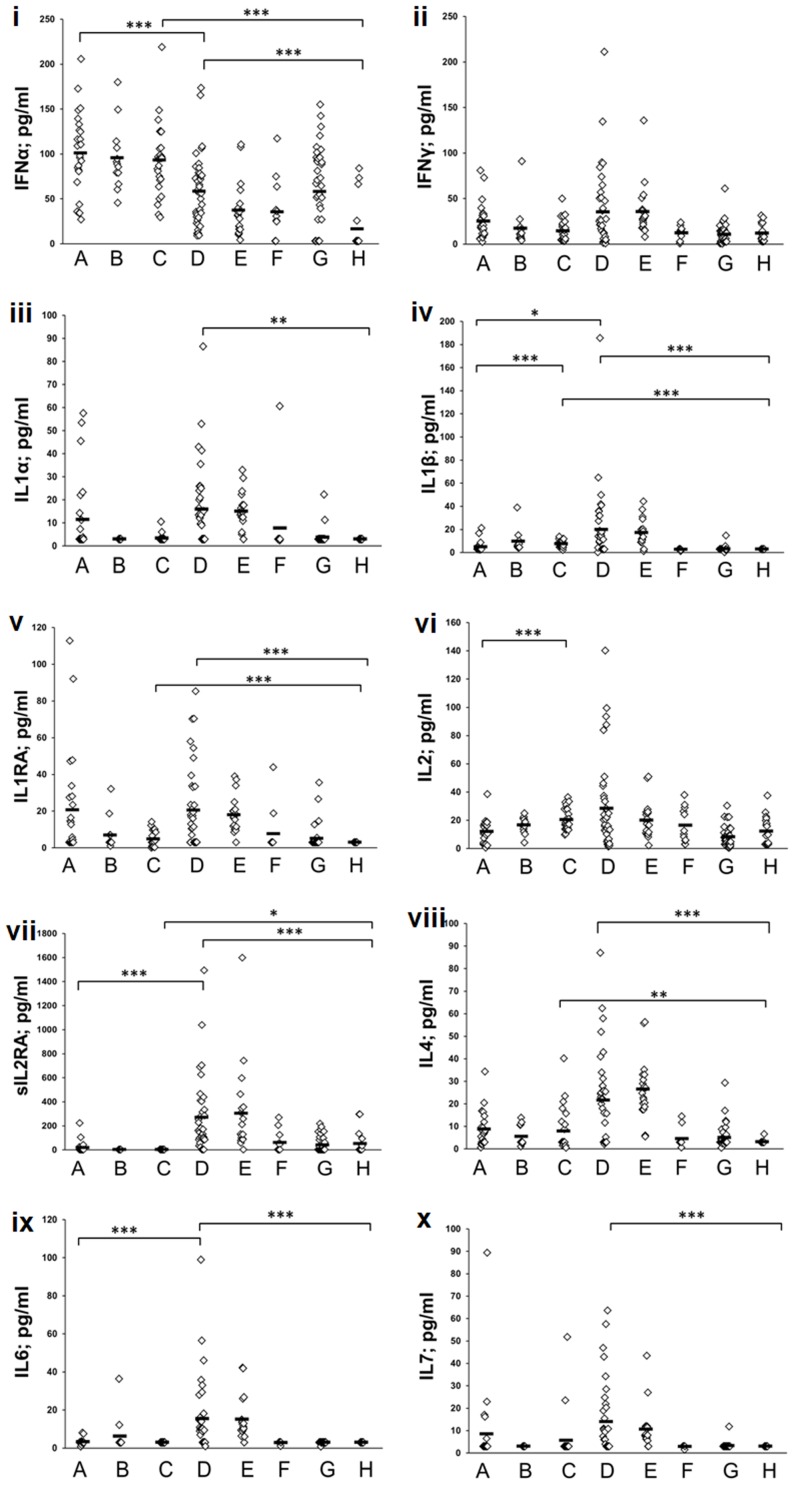
Mean cytokine levels (pg/ml) in the plasma of study subjects belonging to different categories.(A = non-pregnant controls, B = control-pregnant trimester1, C = control-pregnant trimester-2+3, D = acute non-pregnant patients, E = convalescent non-pregnant patients, F = subclinical pregnant trimester 1, G = subclinical pregnant trimester-2+3, H = acute pregnant trimester-2+3 patients). p values are indicated by stars, *p<0.007, **p<0.001, ***p<0.0001.